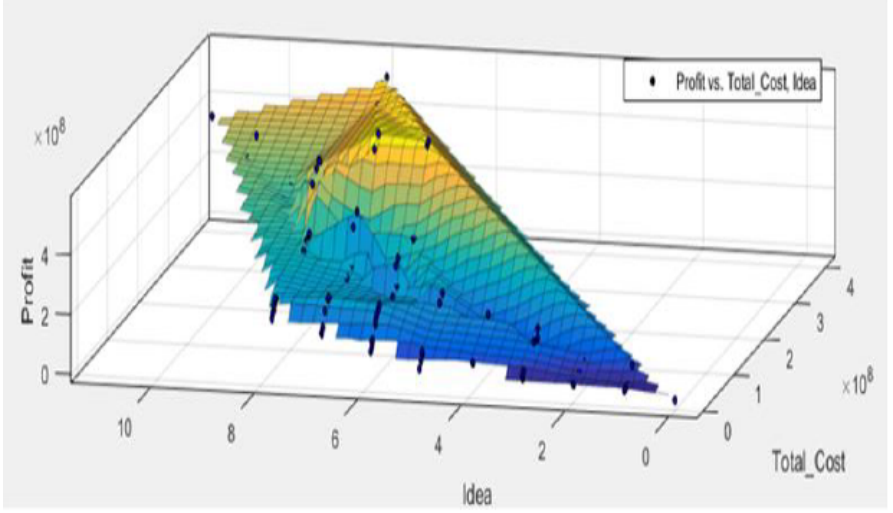
Figure 7. The curve of correlation between ideas, total profit, and profit in advance SMEs.